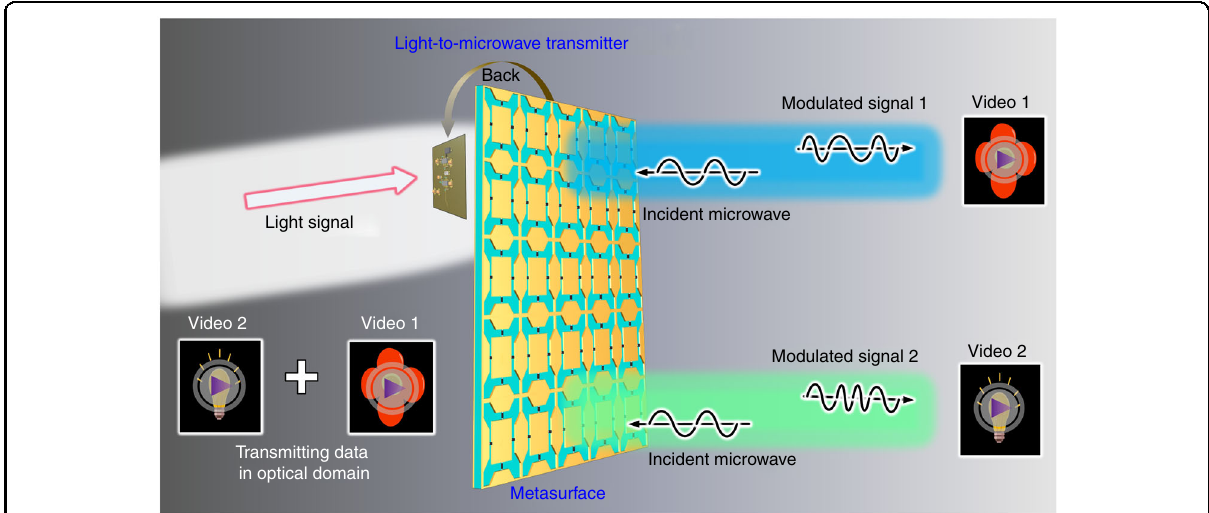
Fig. 1 Schematic of direct light-to-microwave signal conversion using a hybrid optically programmed time-varying metasurface platform. A dual-channel light-to-microwave wireless link is built up via the metasurface-enabled signal converter. In such a system, two different videos can be transmitted and received simultaneously and